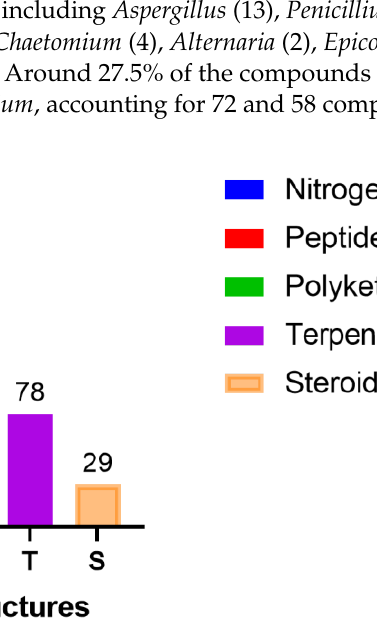
Figure 20. Taxonomy of endophytic fungi isolated from 2002 – 2022. Figure 21. Taxonomy of endophytic fungi isolated from 2002 – 2022.